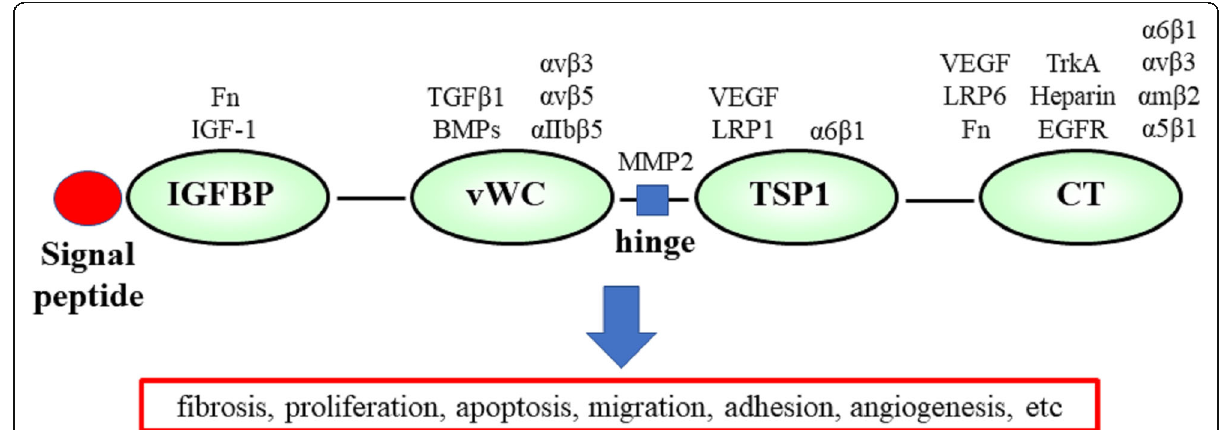
Fig. 1 Schematic representation of the CTGF structure and interaction with the molecules. IGFBP, insulin-like growth factor binding protein domain; vWC, von Willebrand factor C domain; TSP-1, thrombospondin type 1 repeat domain; CT, C-terminal domain. Integrins were shown in each α and β